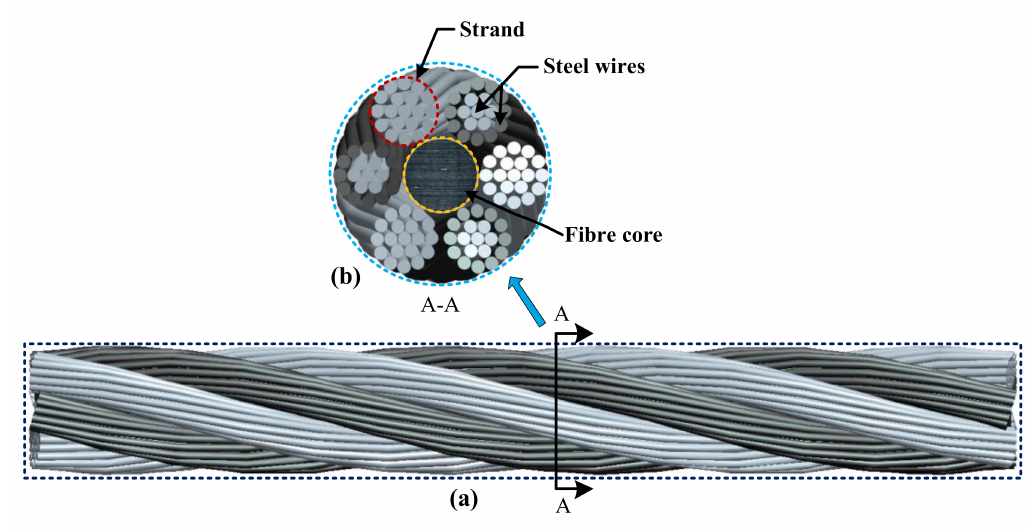
Figure 1. 6 × 19+FC wire rope sample. ( a ) wire rope; ( b ) cross